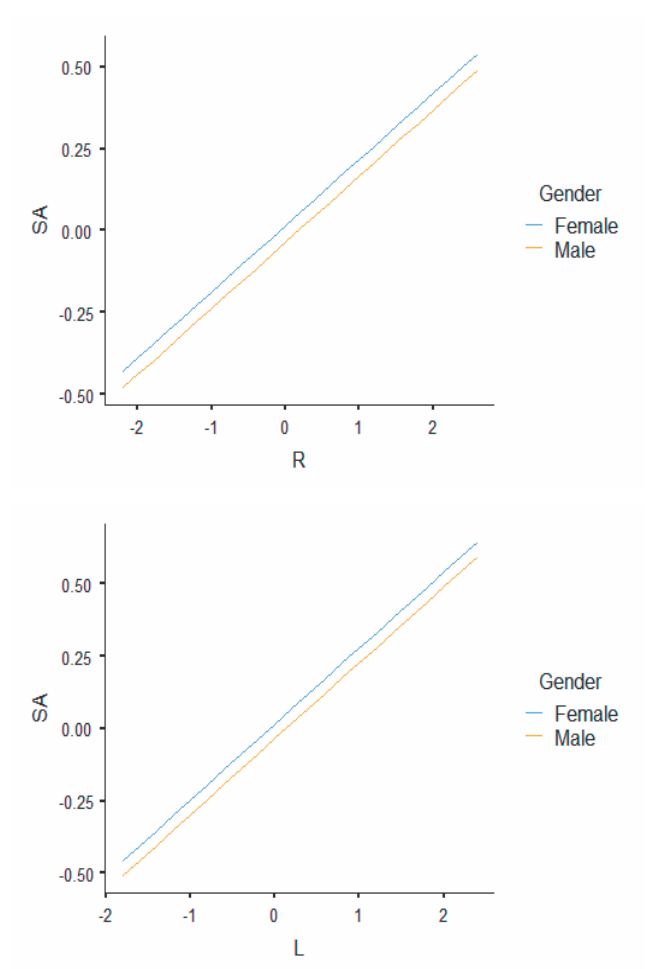
Figure 6. (cid:40)(cid:86)(cid:87)(cid:76)(cid:80)(cid:68)(cid:87)(cid:72)(cid:71)(cid:3)(cid:48)(cid:68)(cid:85)(cid:74)(cid:76)(cid:81)(cid:68)(cid:79)(cid:3)(cid:48)(cid:72)(cid:68)(cid:81)(cid:86)(cid:3)(cid:178)(cid:3)(cid:54)(cid:87)(cid:88)(cid:71)(cid:92)(cid:3)(cid:53)(cid:72)(cid:86)(cid:88)(cid:79)(cid:87)(cid:86)(cid:15)(cid:3)(cid:47)(cid:68)(cid:81)(cid:74)(cid:88)(cid:68)(cid:74)(cid:72)(cid:3)(cid:40)(cid:91)(cid:83)(cid:72)(cid:85)(cid:76)(cid:72)(cid:81)(cid:70)(cid:72)(cid:86)(cid:15)(cid:3) (cid:42)(cid:72)(cid:81)(cid:71)(cid:72)(cid:85)(cid:17) (cid:49)(cid:82)(cid:87)(cid:72) (cid:29)(cid:3)(cid:54)(cid:36)(cid:16)(cid:54)(cid:70)(cid:76)(cid:72)(cid:81)(cid:87)(cid:76)(cid:192)(cid:70)(cid:3)(cid:36)(cid:70)(cid:87)(cid:76)(cid:89)(cid:76)(cid:87)(cid:92)(cid:15)(cid:3)(cid:53)(cid:16)(cid:53)(cid:72)(cid:68)(cid:71)(cid:76)(cid:81)(cid:74)(cid:3)(cid:36)(cid:70)(cid:87)(cid:76)(cid:89)(cid:76)(cid:87)(cid:92)(cid:15)(cid:3)(cid:47)(cid:16)(cid:47)(cid:68)(cid:81)(cid:74)(cid:88)(cid:68)(cid:74)(cid:72)(cid:3)(cid:40)(cid:91)(cid:83)(cid:72)(cid:85)(cid:76)(cid:72)(cid:81)(cid:70)(cid:72)(cid:86)(cid:17) (cid:53)(cid:72)(cid:86)(cid:88)(cid:79)(cid:87)(cid:86)(cid:3)(cid:82)(cid:73)(cid:3)(cid:87)(cid:75)(cid:72)(cid:3)(cid:79)(cid:76)(cid:81)(cid:72)(cid:68)(cid:85)(cid:3)(cid:85)(cid:72)(cid:74)(cid:85)(cid:72)(cid:86)(cid:86)(cid:76)(cid:82)(cid:81)(cid:3)(cid:85)(cid:72)(cid:74)(cid:68)(cid:85)(cid:71)(cid:76)(cid:81)(cid:74)(cid:3)(cid:79)(cid:76)(cid:81)(cid:74)(cid:88)(cid:76)(cid:86)(cid:87)(cid:76)(cid:70)(cid:3)(cid:70)(cid:68)(cid:83)(cid:76)(cid:87)(cid:68)(cid:79)(cid:3)(cid:70)(cid:82)(cid:80)(cid:83)(cid:82)(cid:81)(cid:72)(cid:81)(cid:87)(cid:86)(cid:3)(cid:76)(cid:81)(cid:3) (cid:83)(cid:85)(cid:72)(cid:71)(cid:76)(cid:70)(cid:87)(cid:76)(cid:81)(cid:74)(cid:3)(cid:72)(cid:71)(cid:88)(cid:70)(cid:68)(cid:87)(cid:76)(cid:82)(cid:81)(cid:3)(cid:82)(cid:88)(cid:87)(cid:70)(cid:82)(cid:80)(cid:72)(cid:86)(cid:3)(cid:80)(cid:82)(cid:71)(cid:72)(cid:85)(cid:68)(cid:87)(cid:72)(cid:71)(cid:3)(cid:69)(cid:92)(cid:3)(cid:74)(cid:72)(cid:81)(cid:71)(cid:72)(cid:85)(cid:3)(cid:83)(cid:85)(cid:82)(cid:89)(cid:72)(cid:3)(cid:87)(cid:75)(cid:68)(cid:87)(cid:3)(cid:87)(cid:75)(cid:72)(cid:3)(cid:70)(cid:82)(cid:81)(cid:86)(cid:87)(cid:85)(cid:88)(cid:70)(cid:87)(cid:72)(cid:71)(cid:3) (cid:80)(cid:82)(cid:71)(cid:72)(cid:79)(cid:3)(cid:76)(cid:86)(cid:3)(cid:86)(cid:76)(cid:74)(cid:81)(cid:76)(cid:192)(cid:70)(cid:68)(cid:81)(cid:87)(cid:3)(cid:11)(cid:41)(cid:11)(cid:22)(cid:27)(cid:15)(cid:3)(cid:20)(cid:28)(cid:25)(cid:12)(cid:32)(cid:21)(cid:17)(cid:21)(cid:27)(cid:15)(cid:3)(cid:53)(cid:242)(cid:32)(cid:17)(cid:22)(cid:20)(cid:15)(cid:3)(cid:83)(cid:31)(cid:17)(cid:19)(cid:19)(cid:20)(cid:12)(cid:17)(cid:3)(cid:44)(cid:81)(cid:71)(cid:76)(cid:89)(cid:76)(cid:71)(cid:88)(cid:68)(cid:79)(cid:3)(cid:70)(cid:82)(cid:80)(cid:83)(cid:82)(cid:81)(cid:72)(cid:81)(cid:87)(cid:3)(cid:68)(cid:81)(cid:68)(cid:79)(cid:16) (cid:92)(cid:86)(cid:76)(cid:86)(cid:3)(cid:76)(cid:81)(cid:71)(cid:76)(cid:70)(cid:68)(cid:87)(cid:72)(cid:3)(cid:87)(cid:75)(cid:68)(cid:87)(cid:3)(cid:90)(cid:68)(cid:87)(cid:70)(cid:75)(cid:76)(cid:81)(cid:74)(cid:3)(cid:68)(cid:88)(cid:71)(cid:76)(cid:82)(cid:18)(cid:89)(cid:76)(cid:86)(cid:88)(cid:68)(cid:79)(cid:3)(cid:70)(cid:82)(cid:81)(cid:87)(cid:72)(cid:81)(cid:87)(cid:3)(cid:11)(cid:87)(cid:32)(cid:20)(cid:17)(cid:28)(cid:27)(cid:15)(cid:3)(cid:83)(cid:32)(cid:17)(cid:19)(cid:24)(cid:19)(cid:12)(cid:15)(cid:3)(cid:83)(cid:68)(cid:85)(cid:87)(cid:76)(cid:70)(cid:76)(cid:83)(cid:68)(cid:87)(cid:76)(cid:82)(cid:81)(cid:3) (cid:76)(cid:81)(cid:3)(cid:79)(cid:76)(cid:87)(cid:72)(cid:85)(cid:68)(cid:87)(cid:88)(cid:85)(cid:72)(cid:3)(cid:70)(cid:82)(cid:81)(cid:87)(cid:72)(cid:86)(cid:87)(cid:86)(cid:3)(cid:11)(cid:87)(cid:32)(cid:21)(cid:17)(cid:22)(cid:21)(cid:15)(cid:3)(cid:83)(cid:32)(cid:17)(cid:19)(cid:21)(cid:20)(cid:12)(cid:15)(cid:3)(cid:75)(cid:76)(cid:74)(cid:75)(cid:72)(cid:86)(cid:87)(cid:3)(cid:79)(cid:72)(cid:89)(cid:72)(cid:79)(cid:3)(cid:82)(cid:73)(cid:3)(cid:79)(cid:72)(cid:68)(cid:85)(cid:81)(cid:72)(cid:71)(cid:3)(cid:73)(cid:82)(cid:85)(cid:72)(cid:76)(cid:74)(cid:81)(cid:3)(cid:79)(cid:68)(cid:81)(cid:74)(cid:88)(cid:68)(cid:74)(cid:72)(cid:3) (cid:11)(cid:87)(cid:32)(cid:21)(cid:17)(cid:23)(cid:24)(cid:15)(cid:3)(cid:83)(cid:32)(cid:17)(cid:19)(cid:20)(cid:24)(cid:12)(cid:3)(cid:68)(cid:81)(cid:71)(cid:3)(cid:85)(cid:72)(cid:68)(cid:71)(cid:76)(cid:81)(cid:74)(cid:3)(cid:69)(cid:82)(cid:82)(cid:78)(cid:86)(cid:3)(cid:11)(cid:87)(cid:32)(cid:21)(cid:17)(cid:25)(cid:27)(cid:15)(cid:3)(cid:83)(cid:32)(cid:17)(cid:19)(cid:19)(cid:27)(cid:12)(cid:3)(cid:68)(cid:85)(cid:72)(cid:3)(cid:86)(cid:76)(cid:74)(cid:81)(cid:76)(cid:192)(cid:70)(cid:68)(cid:81)(cid:87)(cid:3)(cid:83)(cid:85)(cid:72)(cid:71)(cid:76)(cid:70)(cid:87)(cid:82)(cid:85)(cid:86)(cid:17)(cid:3)(cid:44)(cid:81)(cid:3) (cid:87)(cid:75)(cid:72)(cid:3)(cid:87)(cid:72)(cid:86)(cid:87)(cid:72)(cid:71)(cid:3)(cid:80)(cid:82)(cid:71)(cid:72)(cid:79)(cid:3)(cid:68)(cid:86)(cid:3)(cid:68)(cid:81)(cid:3)(cid:76)(cid:81)(cid:71)(cid:76)(cid:89)(cid:76)(cid:71)(cid:88)(cid:68)(cid:79)(cid:3)(cid:70)(cid:82)(cid:80)(cid:83)(cid:82)(cid:81)(cid:72)(cid:81)(cid:87)(cid:15)(cid:3)(cid:74)(cid:72)(cid:81)(cid:71)(cid:72)(cid:85)(cid:3)(cid:68)(cid:86)(cid:3)(cid:68)(cid:3)(cid:80)(cid:82)(cid:71)(cid:72)(cid:85)(cid:68)(cid:87)(cid:76)(cid:81)(cid:74)(cid:3)(cid:73)(cid:68)(cid:70)(cid:87)(cid:82)(cid:85)(cid:3)